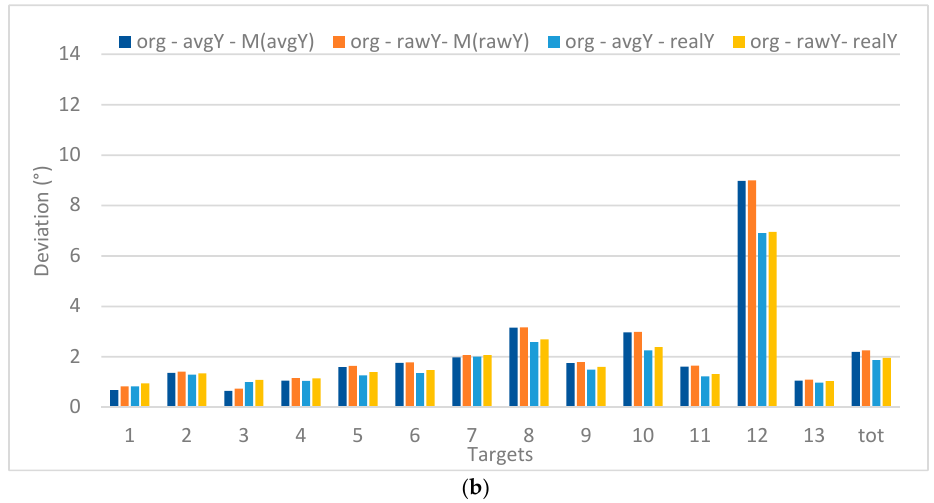
Figure 9. Deviations between de recorded values, average values and real values for X ( a ) and Y ( b ) (in °). Figure 10 focusses on the deviations for each of the target position, compared to their real position. For the 13 targets, a large difference between the filtered and unfiltered data is apparent, which is not the case for the data when there were five targets. This is also confirmed by the Univariate ANOVA test presented in Table 4, which also shows the interaction effect between filtering and the type of target. Although the overall values for the five-target stimuli are much lower, no significant difference is found. The difference between the avg and raw values is also not found to be significant.